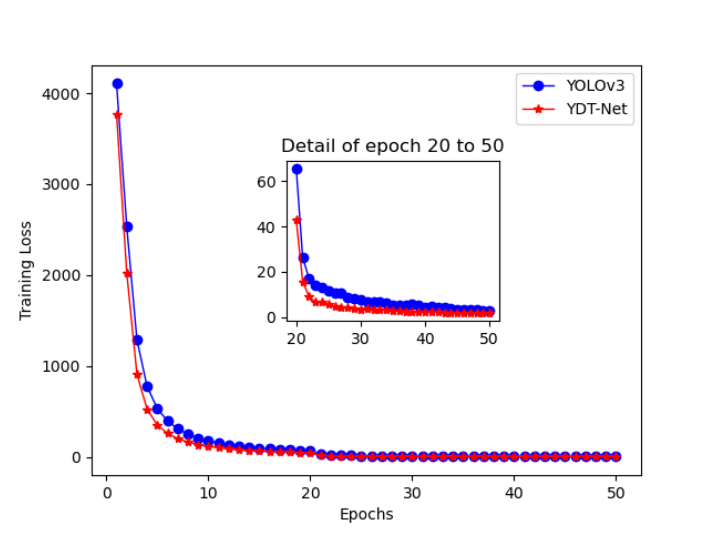
Figure 7. The convergence speed of YOLOv3 and YOT-Net. The red line, refers to YOT-Net, and converges more quickly than blue line for YOLOv3.